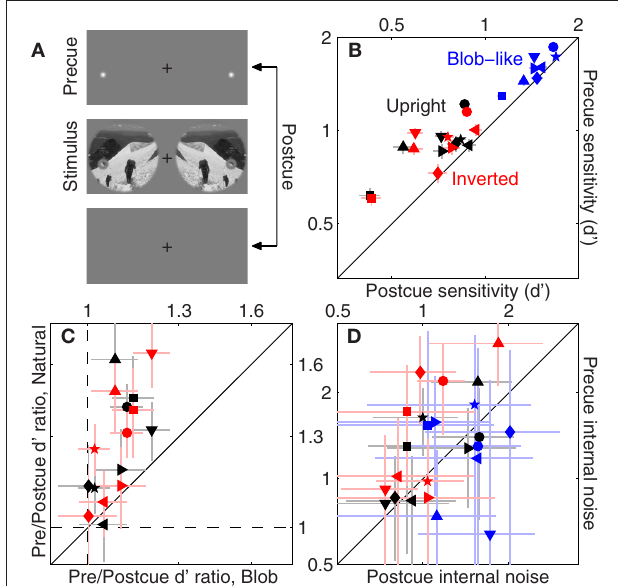
Figure 6 | effect of spatial cueing on sensitivity. We presented two spatial cues located at both target and non-target probes on each trial [top icon in (A) ]; on some trials (randomly selected) the cues appeared before the stimulus (precue trials), on other trials they appeared after the stimulus (postcue trials). (B) Plots d ′ for precue trials on the y axis versus d ′ for postcue trials on the x axis. (D) Plots the same but for internal noise. (C) Plots ratios between d ′ on precue trials and d ′ on postcue trials, for blob-like images on the x axis versus natural (both upright in black and inverted in red) on the y axis. Dashed lines indicate